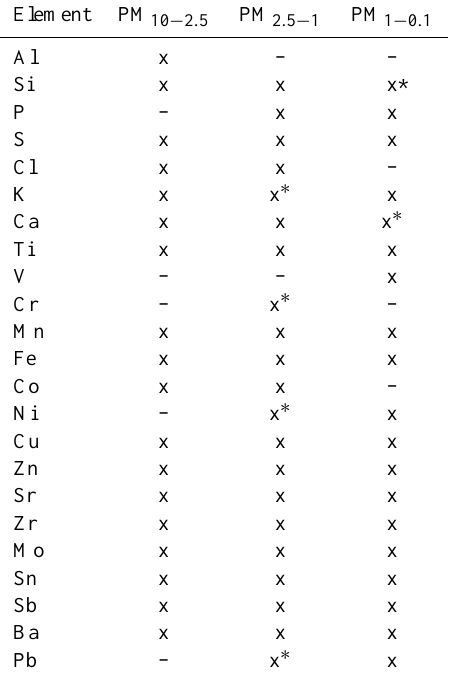
Table 1. List of elements finally retained in the data set (indi- cated with an “x”) having more than 50% of values above detection limit and not more than 20% of replaced missing values. Elements marked with an asterisk ( ∗ ) had a signal-to-noise ratio of S/N< 2 and were thus included as weak